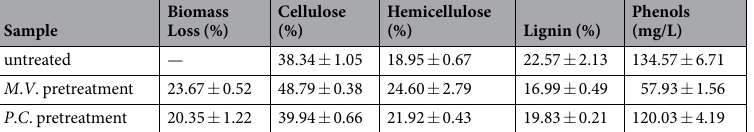
Table 1. Effects of bio-pretreatment on major components of corn stover after fermentation for 14 d. Notes: Values of cellulose, hemicellulose and lignin after bio-pretreatment were presented as the relative content. Degradation rate of cellulose after M . V . pretreatment = [10 × 38.34% − (10 − 10 × 23.67%) × 48.79%]/ (10 × 38.34%) × 100% = 2.78%, the other degradation rate of each components after different pretreatment were calculated by the same method, and the degradation rate of cellulose after P . C . pretreatment was 17.02%; the degradation of lignin degradation rate after M . V . pretreatment was 42.30%; the degradation of lignin degradation rate after P . C . pretreatment was 30.04%. Each value was the mean of the three